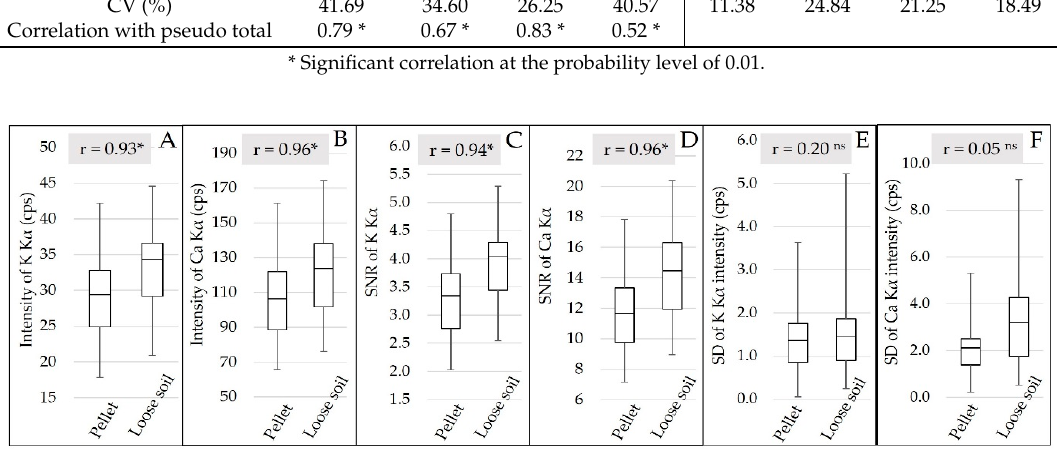
Figure 5. Box plot of the K α emission line intensity of K and Ca ( A and B , respectively), after averaging the replicates. Box plot of the signal-to-noise ratio (SNR) of the K α emission lines of K and Ca ( C and D , respectively), after averaging the replicates. Box plot of the standard deviation (SD) of the K α emission line intensity of K and Ca ( E and F , respectively) for the replicates. The Pearson correlation between the pellet and loose soil is also presented (correlations followed by * were significant at the probability level of 0.01; correlations followed by ns were not significant).